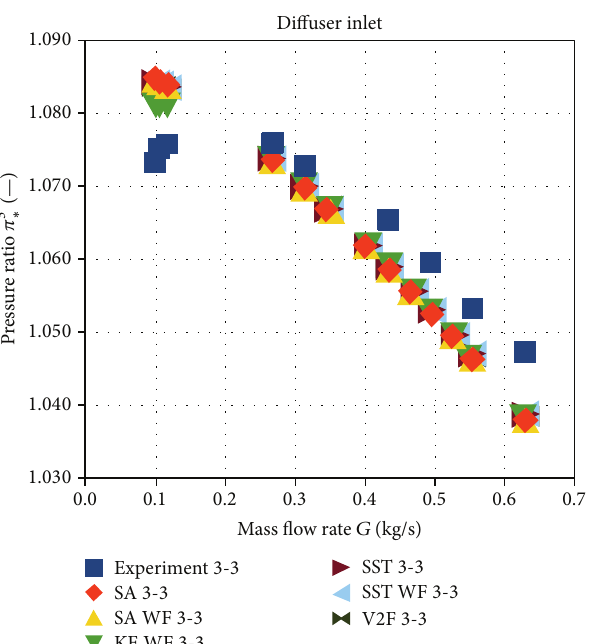
Figure 6: Pressure characteristic at the diffuser outlet for different turbulence models using first-order upwind discretization.